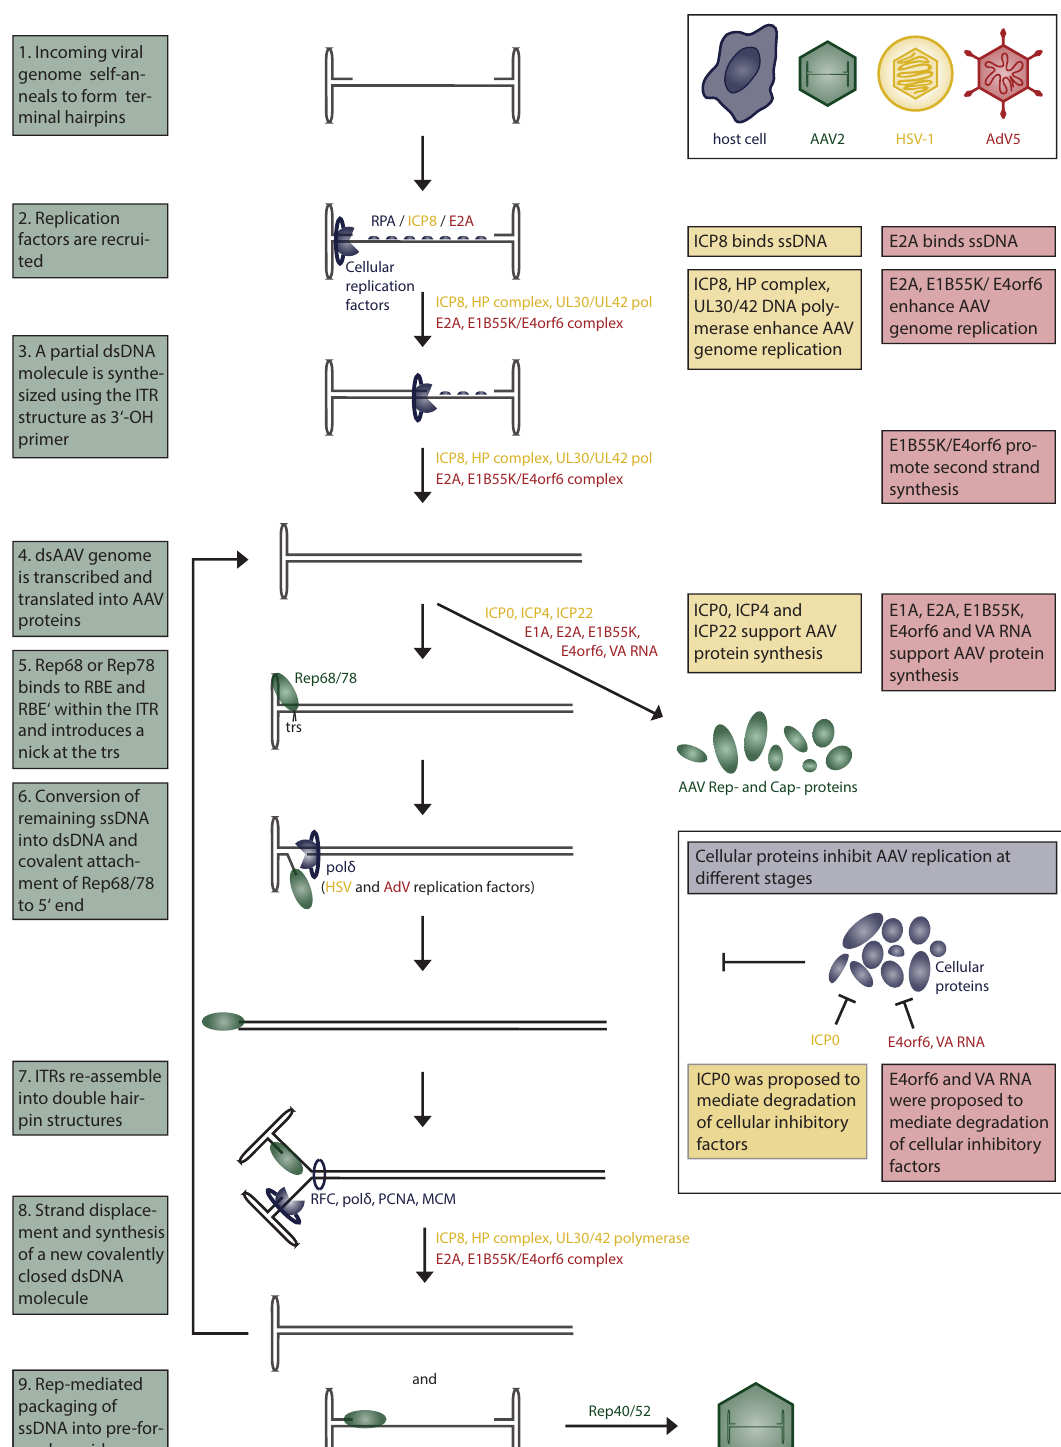
Figure 1. Boxed texts on the left (green) describe each step during AAV replication. The role of HSV-1 (yellow) or AdV5 (red) helper factors and interfering cellular factors (purple) are indicated in the figure and described on the right. AAV Rep-proteins are depicted in green. HSV-1 and AdV5 helper factors in Step 6 are unclear and, therefore, put in